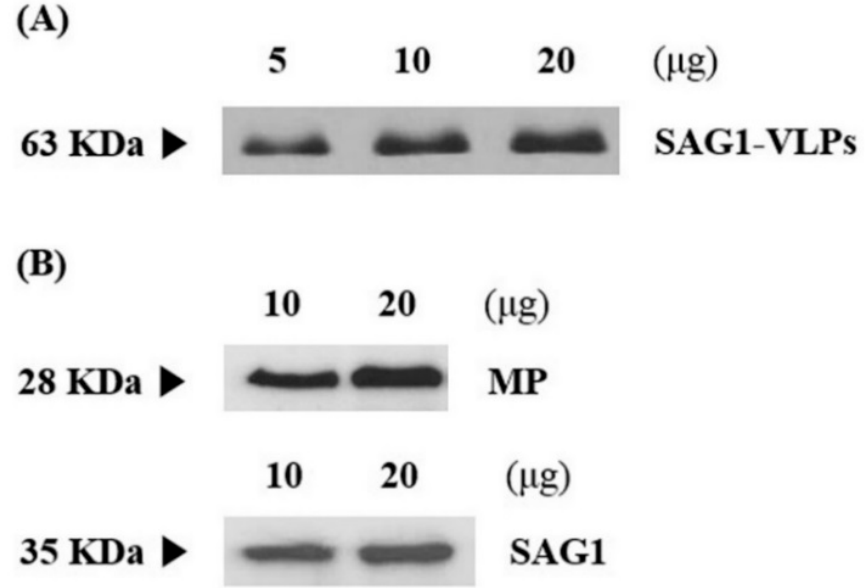
Figure 3. Western blot analysis of specific factors that construct VLPs. ( A ) SAG1-VLPs (63 KDa) expressed from the pFastBac vector containing SAG1 and matrix protein 1. ( B ) The matrix protein 1 (MP; 28 KDa) expressed from the pFastBac vector without T. gondii SAG1, and the SAG1 (35 KDa) expressed from the pFastBac vector without matrix protein 1. The proteins were loaded 5, 10, and 20 µ g on SDS-PAGE, respectively. The polyclonal mouse anti- T. gondii antibody and monoclonal mouse anti-matrix protein 1 antibody were used as a probe to detect SAG1 and matrix protein 1, respectively.